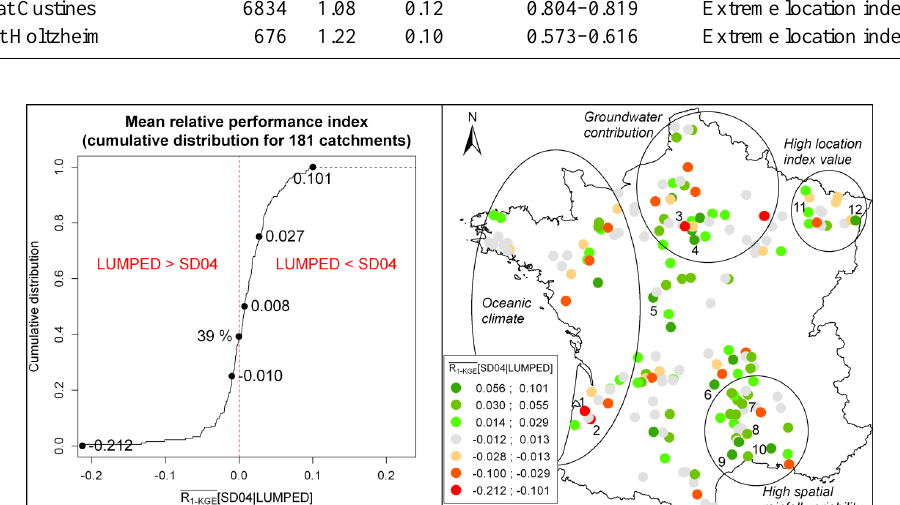
Figure 13. Relative performance index averaged by catchment: (left) cumulative distribution; 3 (right) geographic distribution. The number refers to the particular catchments discussed in 4 Table 4. Green colors (R 1-KGE > 0) indicate better performance of the semi-distributed 5 approach. 6